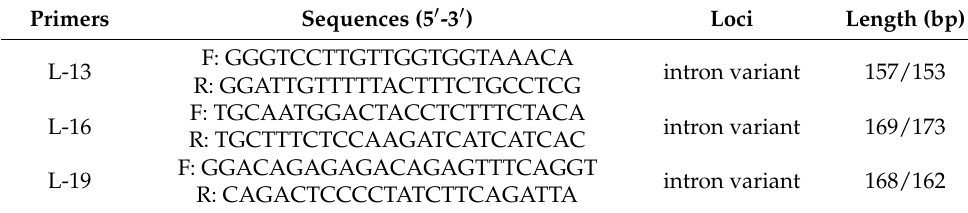
Table 1. PCR primers used to amplify target